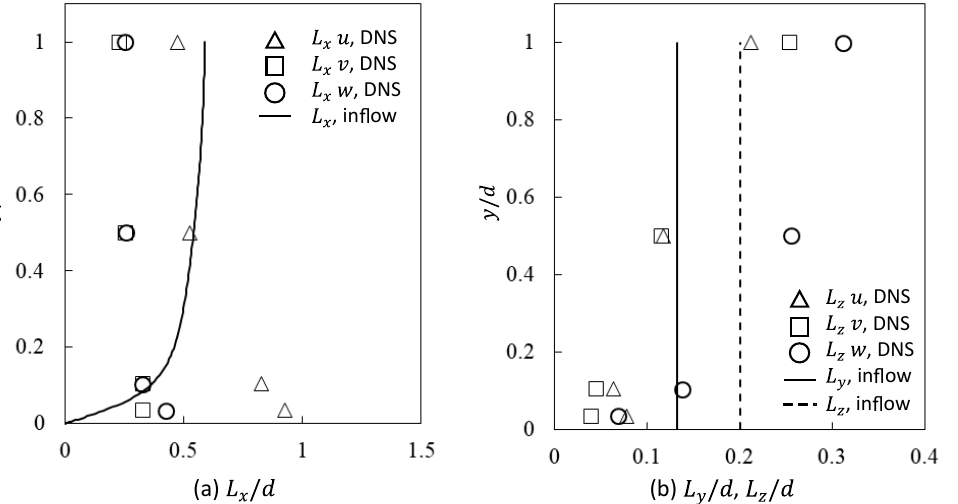
Figure 2. Integral length scales (symbol: two-point correlation in DNS data; line: inflow